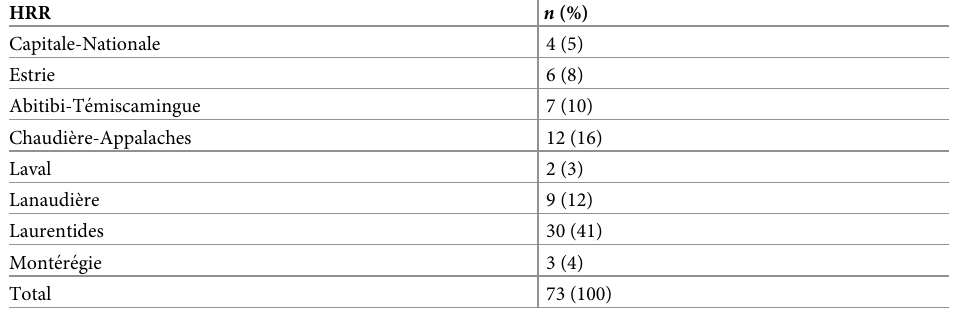
Table 4. Number and percentage of investigated cases by health region of residence (HRR) in Que´bec, Canada, 2016–2017. HRR n (%) Capitale-Nationale